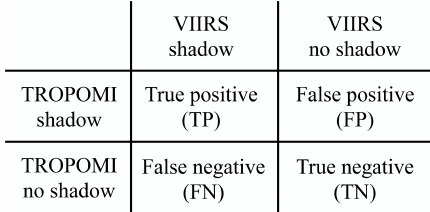
Figure 10. Confusion matrix of the shadow detection on the TROPOMI Level 2 UVIS grid. TROPOMI shadows are detected with the PCSF or ACSF of DARCLOS. VIIRS shadows are manu- ally determined by visual inspection of VIIRS true-colour